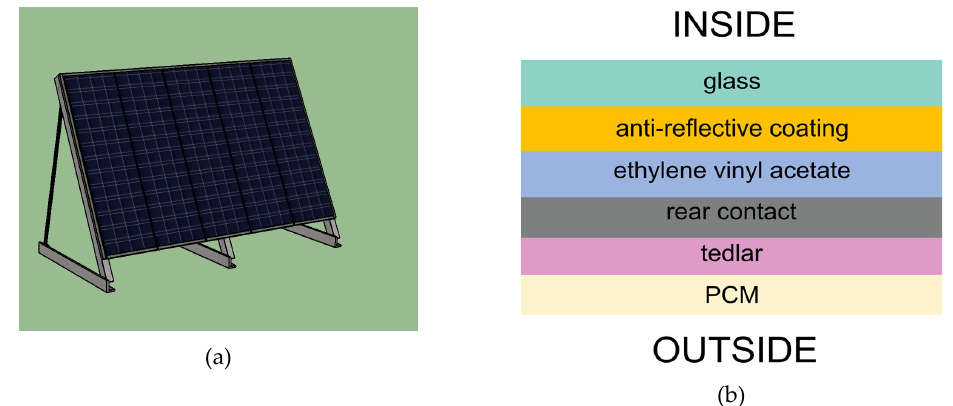
Figure 2. ( a ) Photovoltaic panel modeled in Sketchup ; ( b ) panel configuration to see the position of the Phase Change Material (PCM) . Phase Change Material